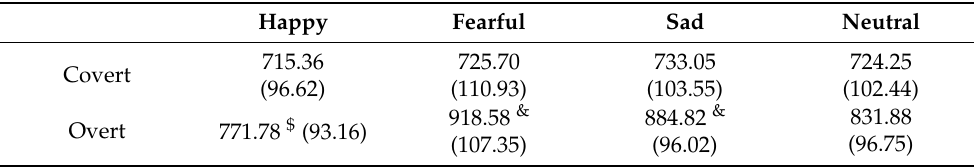
Table 1. Mean RTs (ms) and standard deviations by Condition and Emotion.